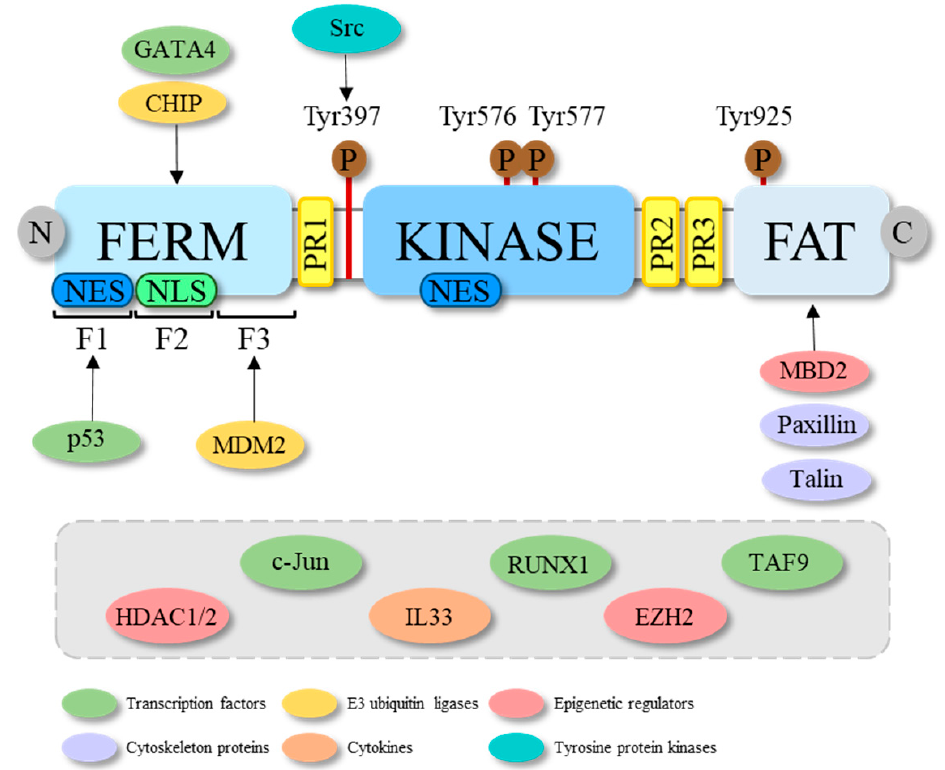
Figure 1. Schematic representation of the molecular structure of FAK and some of its interactors. FAK structure consists of three main domains: the N-terminal FERM, the central kinase and the C-terminal FAT domain. The FERM domain includes three lobes, i.e., F1, F2 and F3, which are bound from transcription factors (among which are GATA4 and p53) and E3 ubiquitin ligases (among which are CHIP and MDM2). While it is known that p53 and MDM2, respectively, bind the F1 and F3 lobes of the FERM of FAK, for GATA4 and CHIP it is, only known that they bind the FERM domain, but unknown is to which of its three lobes. In the FERM domain a nuclear export signal (NES) in the lobe F1 and a nuclear localization signal (NLS) in the lobe F2, responsible for the nuclear export and localization of the protein, are reported. A NES is also found in the kinase domain. FAK structure further comprises three proline-rich (PR) regions that serve as binding sites for the Src homology (SH) 3 domains of several proteins. The main phosphorylation sites are shown with brown circles. In particular, the Tyr397 activation site, the Tyr576 and Tyr577 in the activation loop and the Tyr925 binding site for the SH2 domains are reported. The arrows indicate the FAK domain to which some of its interactors bind, while the grey rectangle shows the FAK interactors with still unknown binding